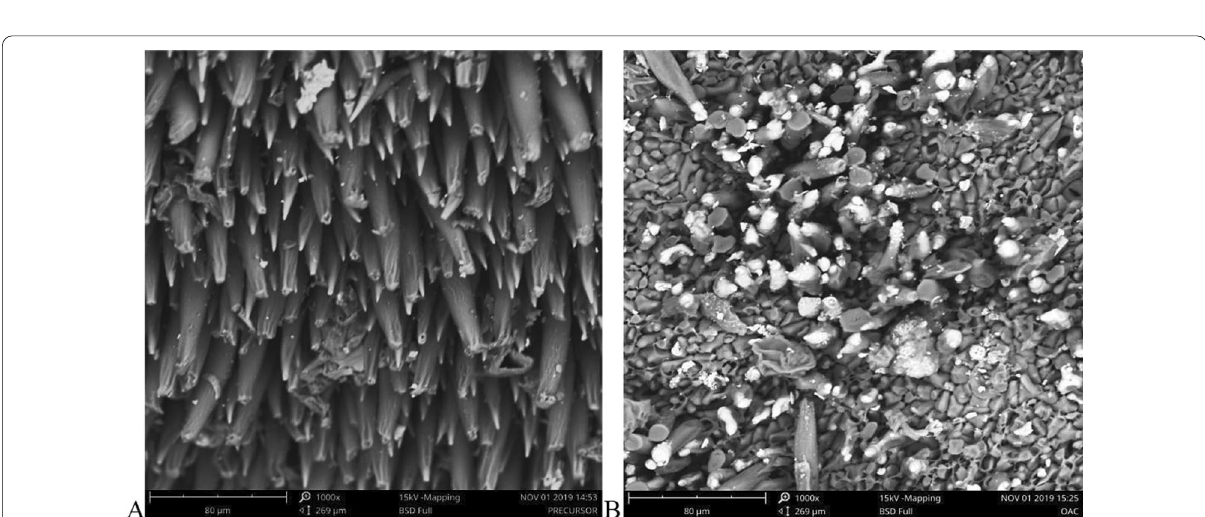
Fig. 4 SEM micrographs of a raw Dialium guineense pods and b Dialium guineense pods active